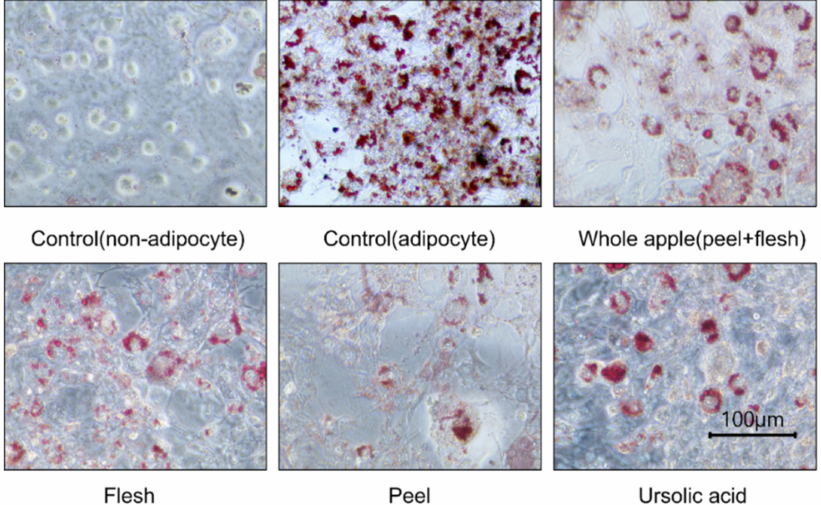
Figure 3. 3T3-L1 cell adipocyte images, observed and photographed using a microscope ( × 400) after cellular lipid accumulation was stained with Oil-Red O solution. The cells were from 70% methanol- treated extracts (1 µ g dry powder in 1 mL of DMSO) of peel, flesh, and whole apple (peel + flesh) concentrated samples, or those treated with ursolic acid 5 µ M. During the three repetitions of the treatments, a representative photograph was